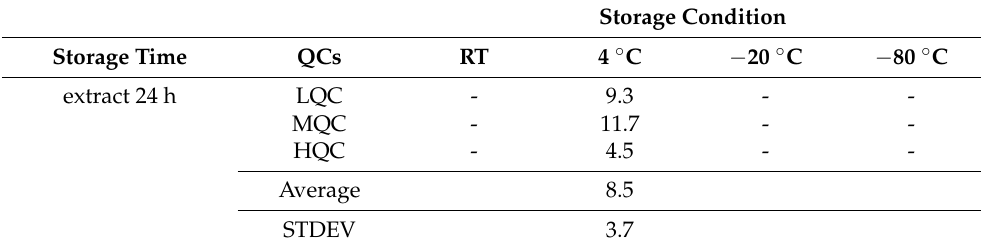
Table 3. Percentage of degradation of fortified plasma samples were tested after storage at room temperature for 24 hours (h); at 4 ◦ C, − 20 ◦ C and -80 ◦ C for 24 h, 48 h, 7 days (d) and 15 days. Stability in the autosampler was tested by storing the extracts at 4 ◦ C for 24 and 48 h. STDEV = standard deviation (see Section